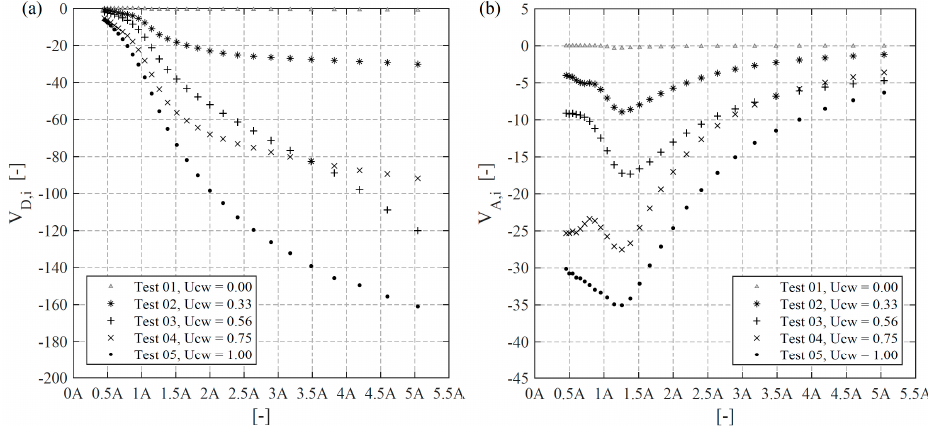
Figure 6. ( a ) Dimensionless eroded sediment volume 𝑉 (cid:3005),(cid:3036) (see Equation (3)) as function of the distance from the center of the structure A; ( b ) cumulative eroded volume 𝑉 (cid:3002),(cid:3036) (see Equation (4)) in dependency to the dimensionless distance A given times the structure footprint of 0.55 m, 1 A = 0.55 m/0.55 m